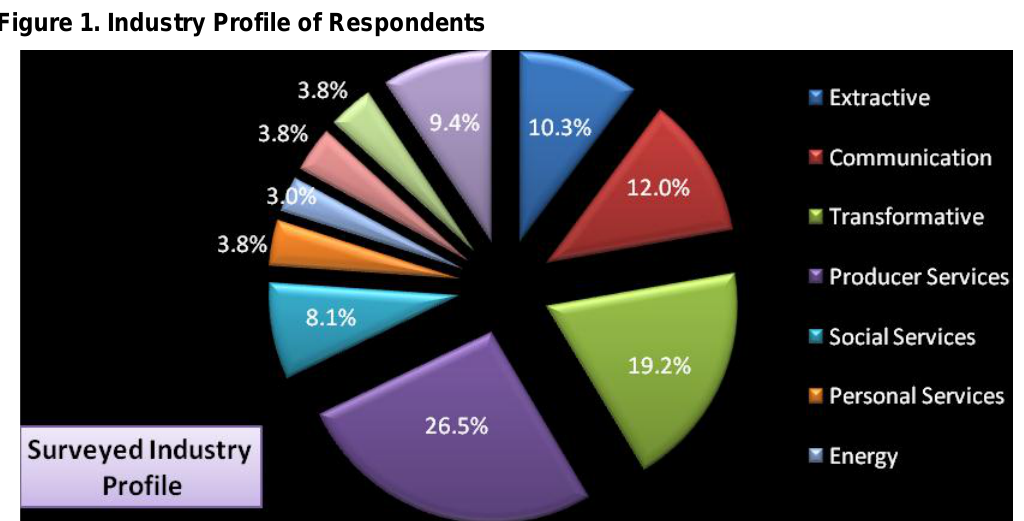
Figure 1. Industry Profile of Respondents